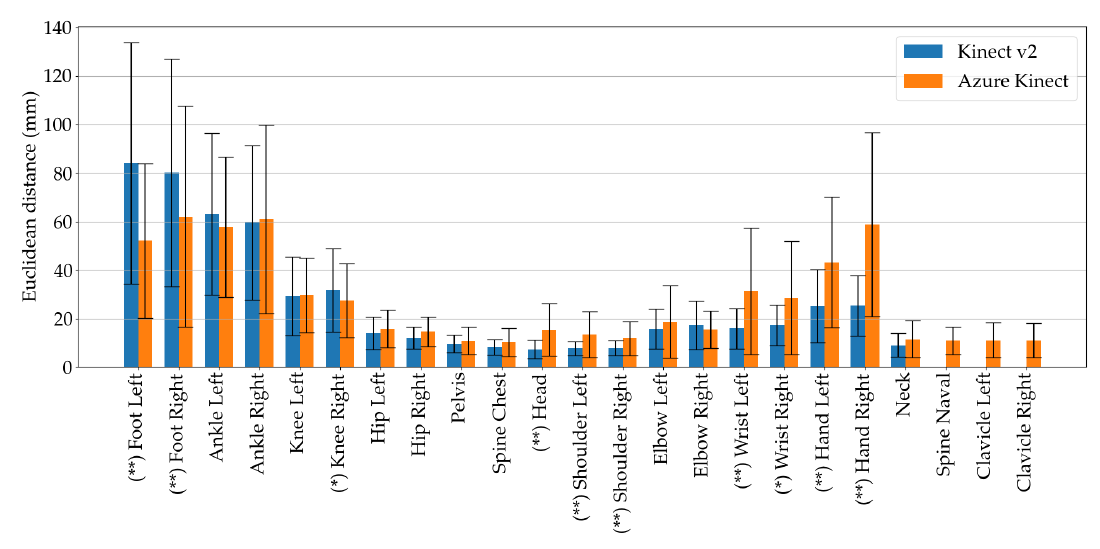
Figure A2. Spatial agreement between Microsoft Kinect v2 and Azure Kinect for 3.9 kmh − 1 .